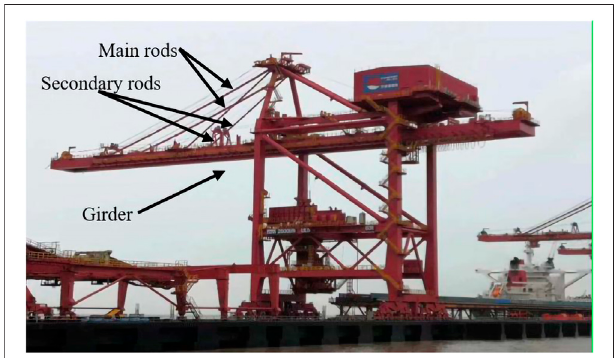
FIGURE 6 | Integral structure of the bridge crane.